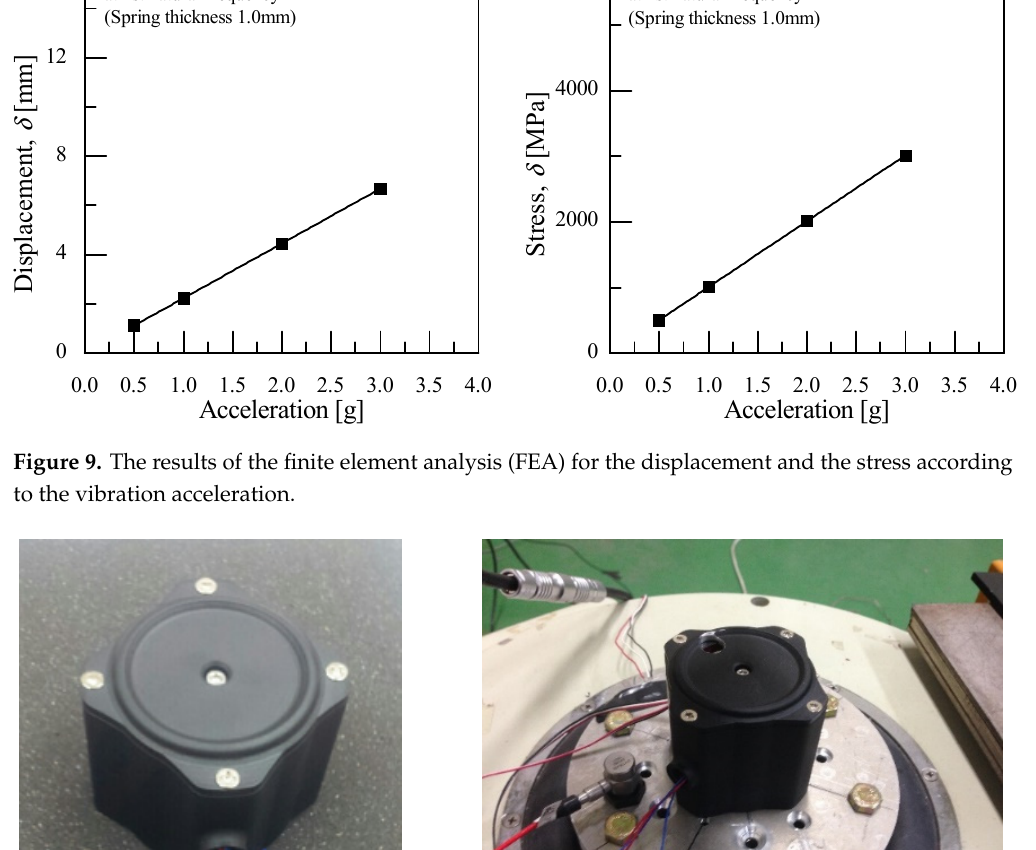
Figure 8. The finite element analysis (FEA) model of the VEH device and the stress distribution on the spring.